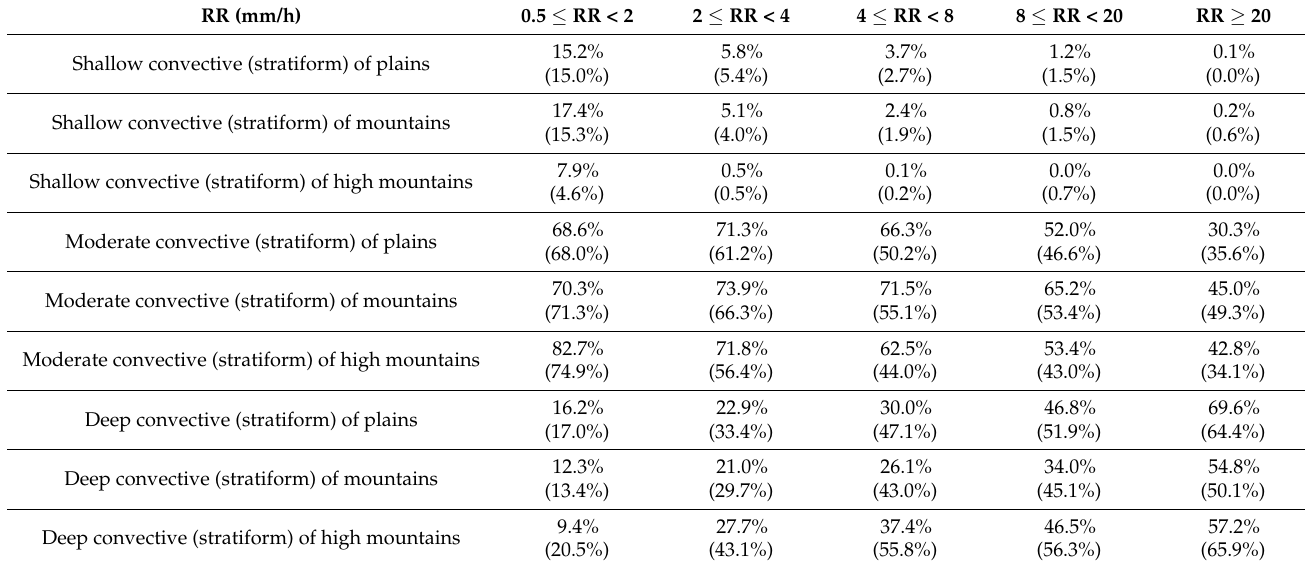
Table 2. Statistics on the proportion of shallow convective (stratiform), moderate convective (strati- form) and deep convective (stratiform) over different types of terrain in the Sichuan Basin and its surrounding detected by GPM DPR from May to September of 2014–2021.